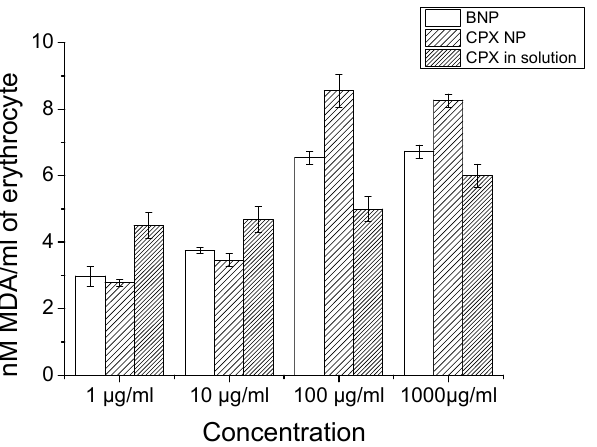
Figure 6. CPX-loaded chitosan nanoparticle exposure to the cells and membrane damage of cells assessed by lipid peroxidation assay ( n = 3, ±SD).